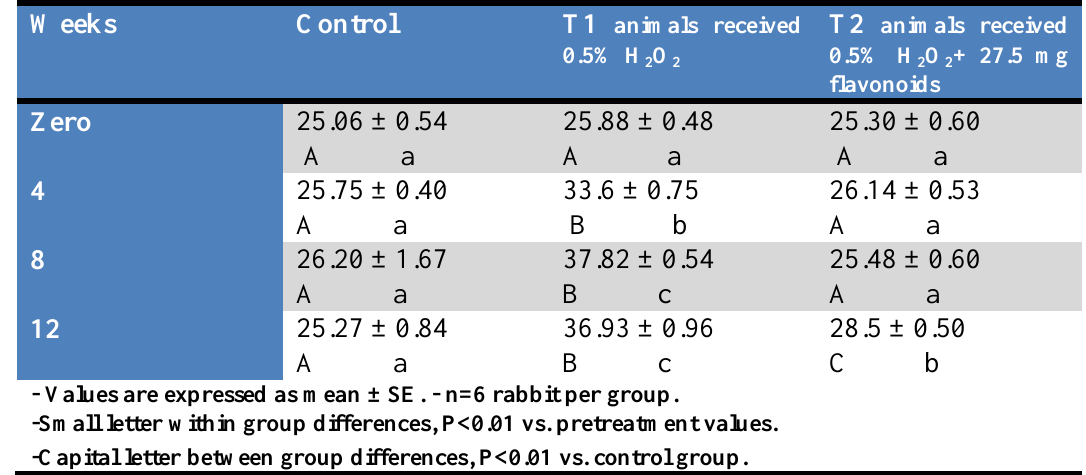
Table (9): Effect of flavonoids extracted from black cumin seeds for twelve weeks on serum very low density lipoprptein (VLDL-C) concentration (mg/dl) in control and H O treated adult male 2 2